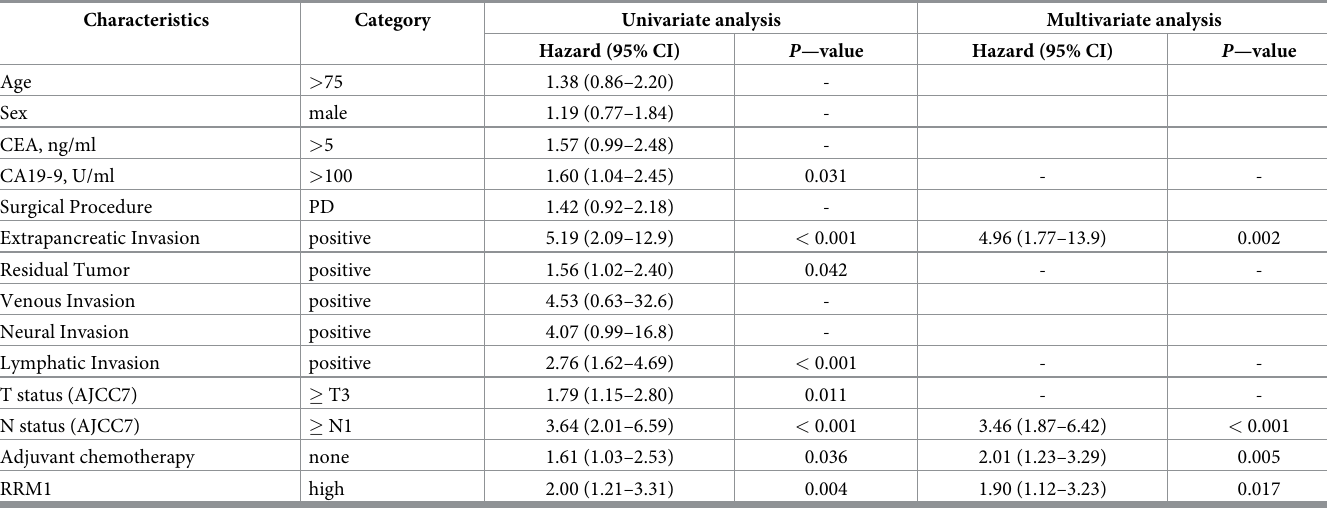
Table 2. Cox proportional analysis for the prognostic factors of overall